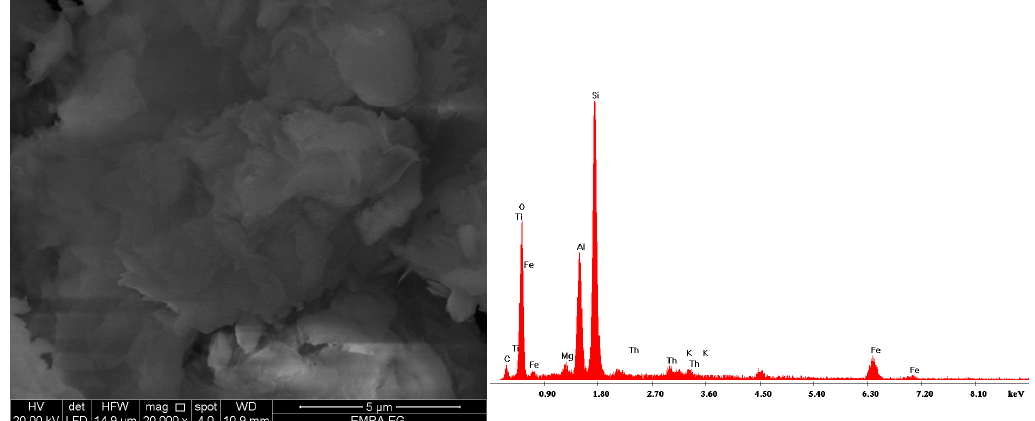
Figure 4. SEM images and EDX of and Th(IV) ions loaded HQ-bentonite.